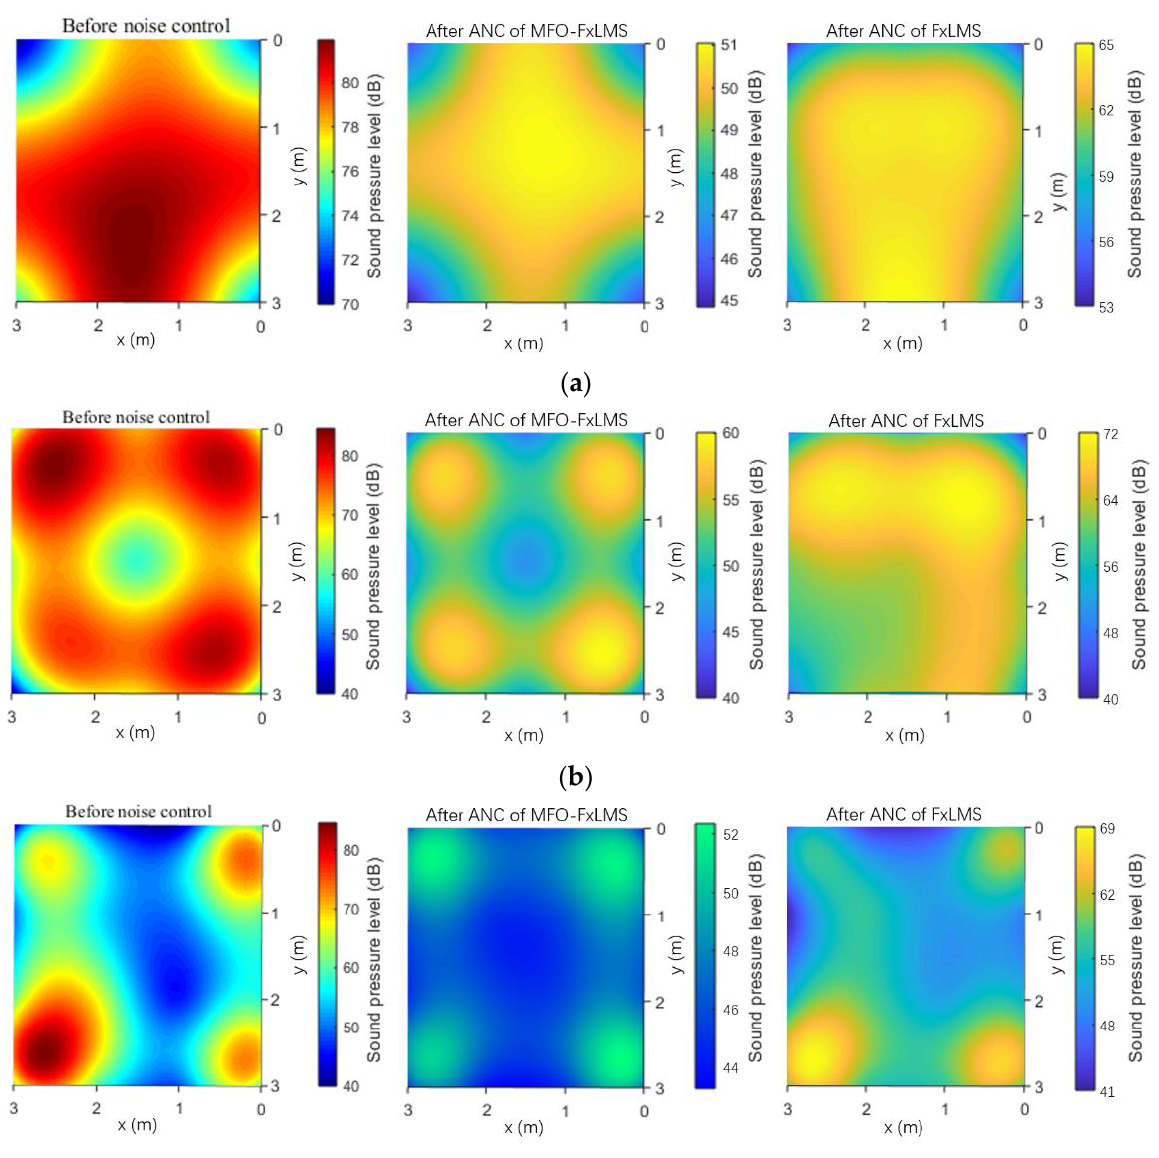
Figure 4. Comparison of noise cancellation performance of two algorithms: ( a ) Time domain diagram; ( b ) Frequency domain diagram.